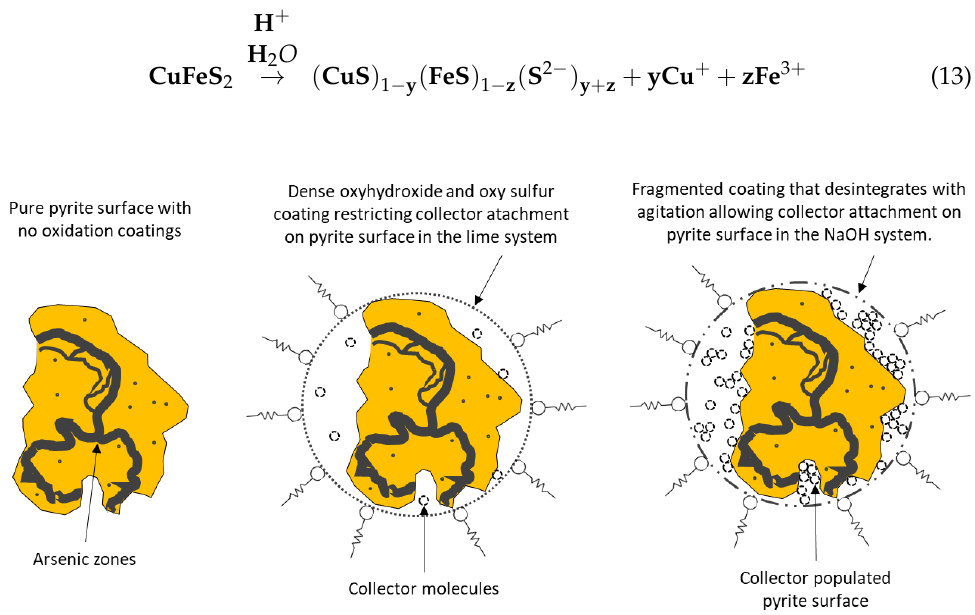
Figure 20. Schematic representation of the pyrite surfaces without treatment ( left ), with lime treat- ment ( center ), and with NaOH treatment ( right ) (adapted from John et al. [80]).